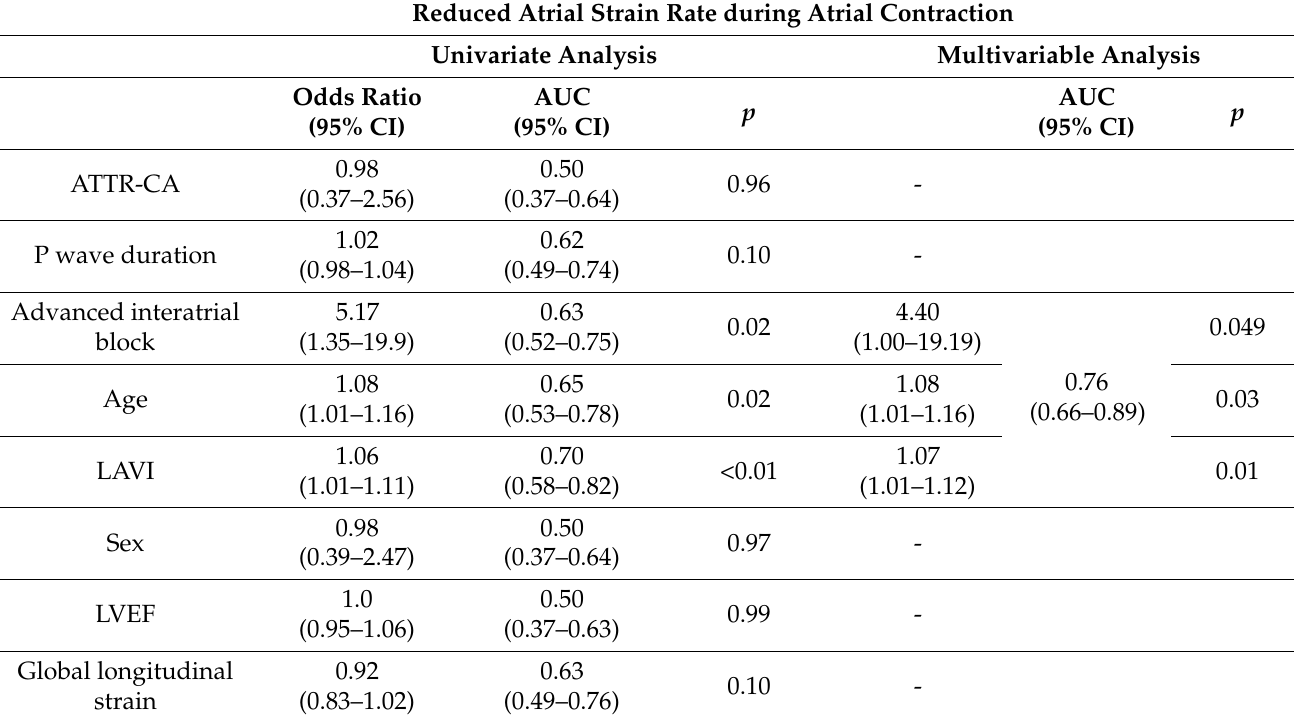
Table 3. Univariate and multivariable